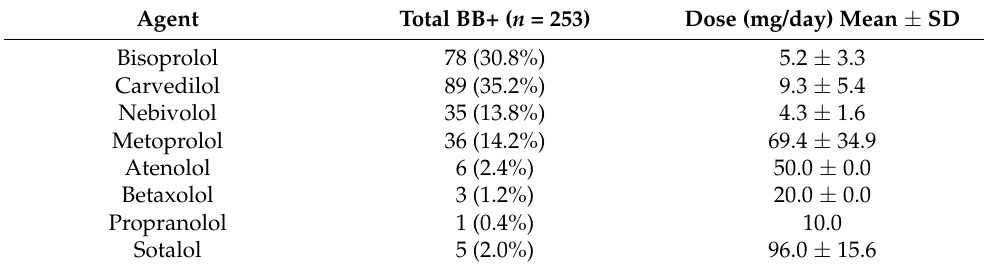
Table 5. Beta-blocker agents identified in the BB+